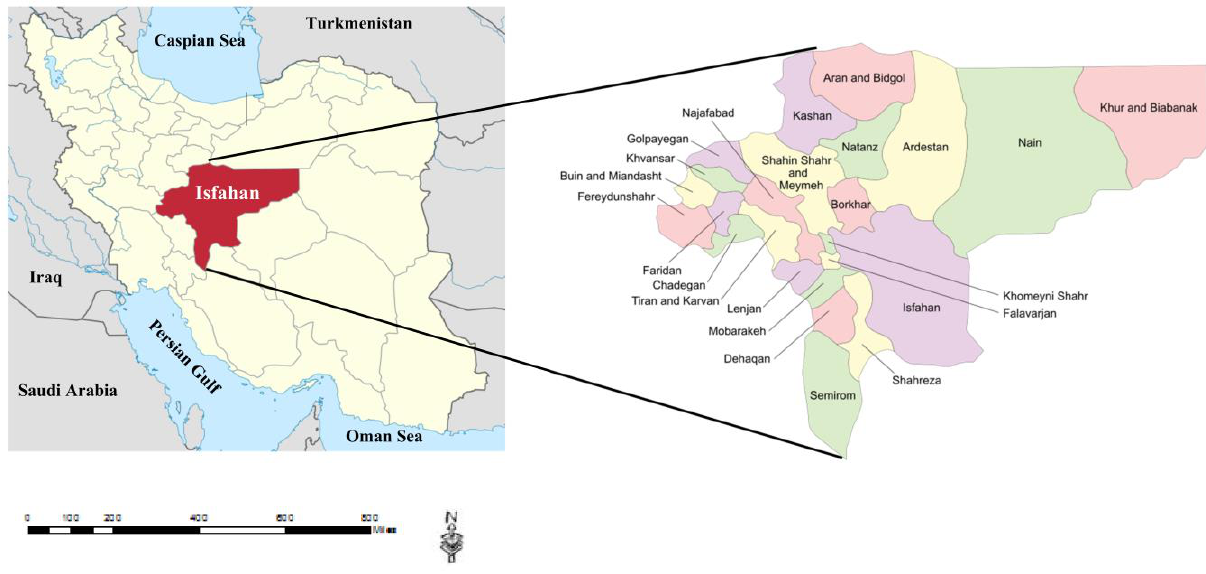
Figure 1. Position of Isfahan province in Iran.